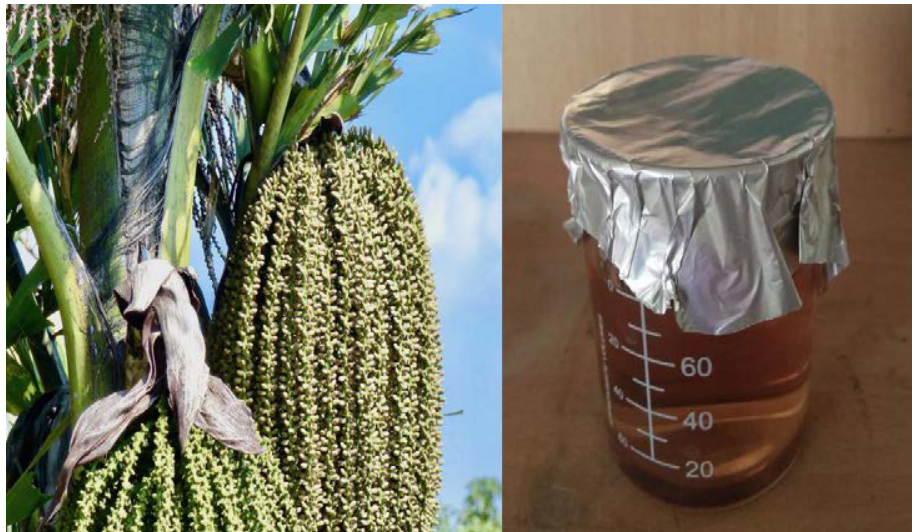
Fig. 1. External morphology of C. urens and nanoparticle